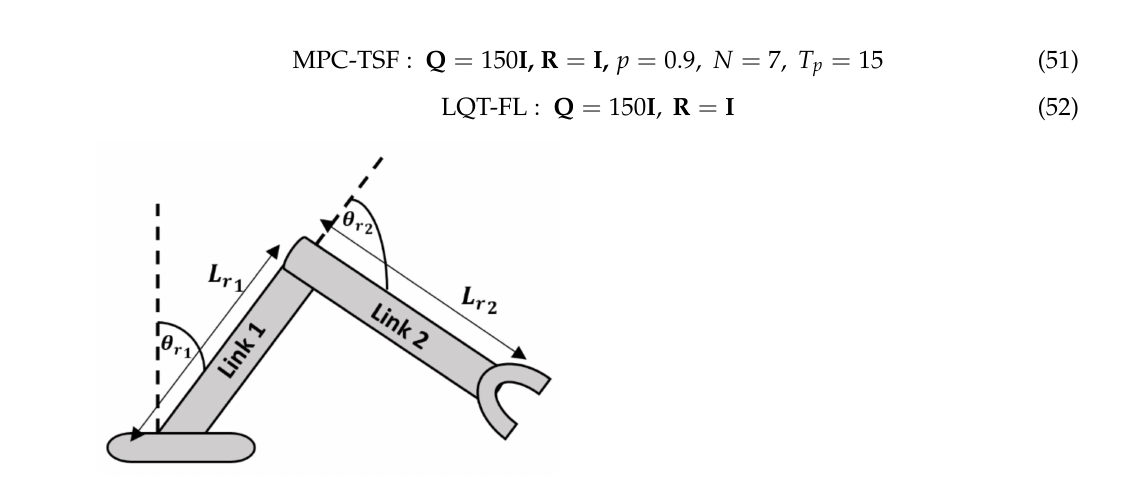
Figure 9. Two-link robot arm.